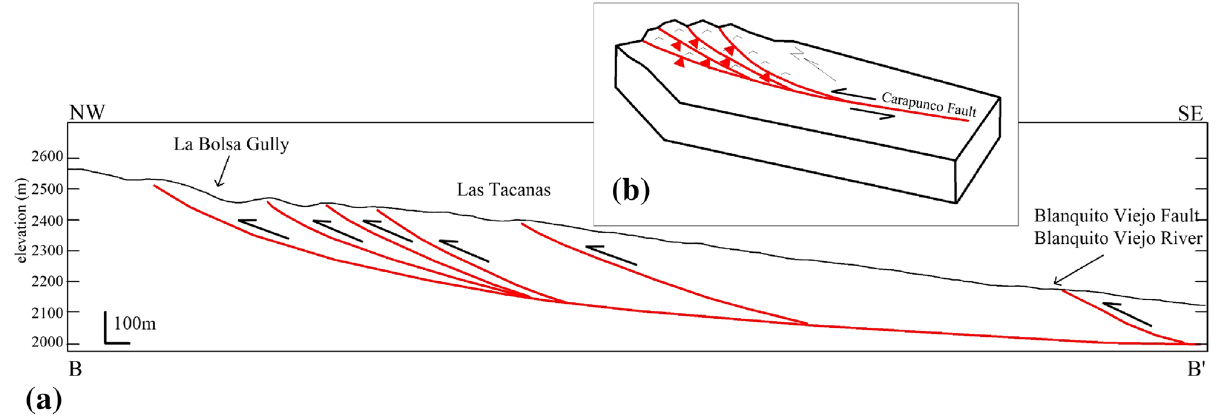
etry of interposed contractional fans drawn based on the distribu‑ tion of the drainage network in Fig. 2 and the attitudes of the fault